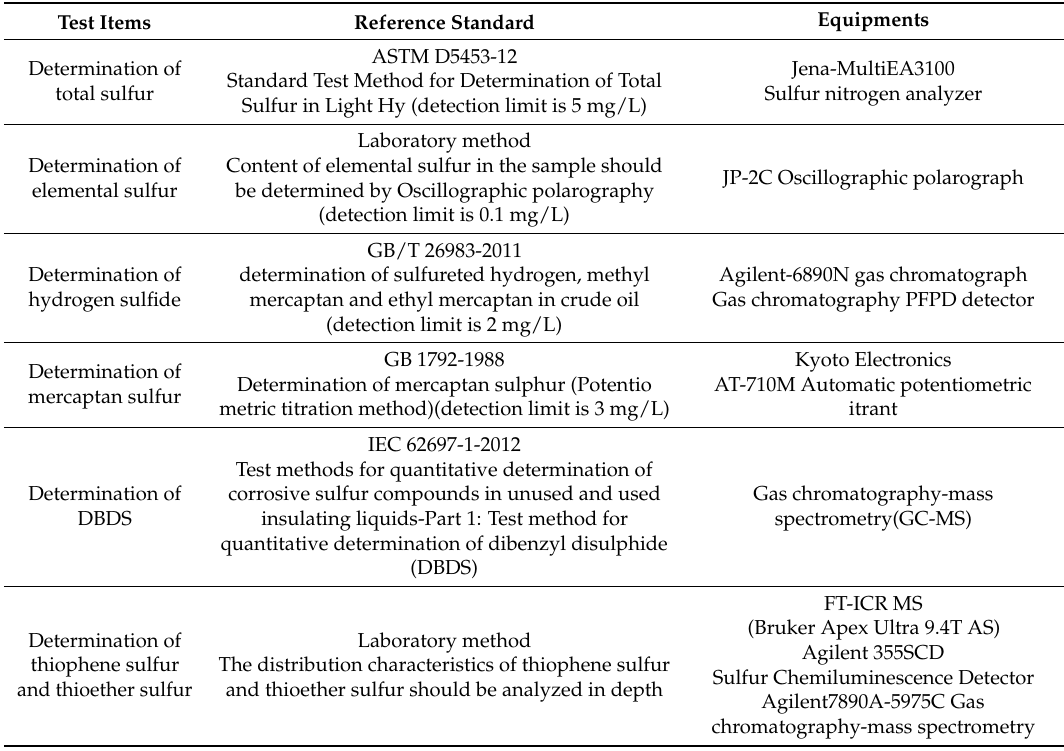
Table 2. Reference standards and equipment for the quantitative determination of different sulfur compounds in transformer